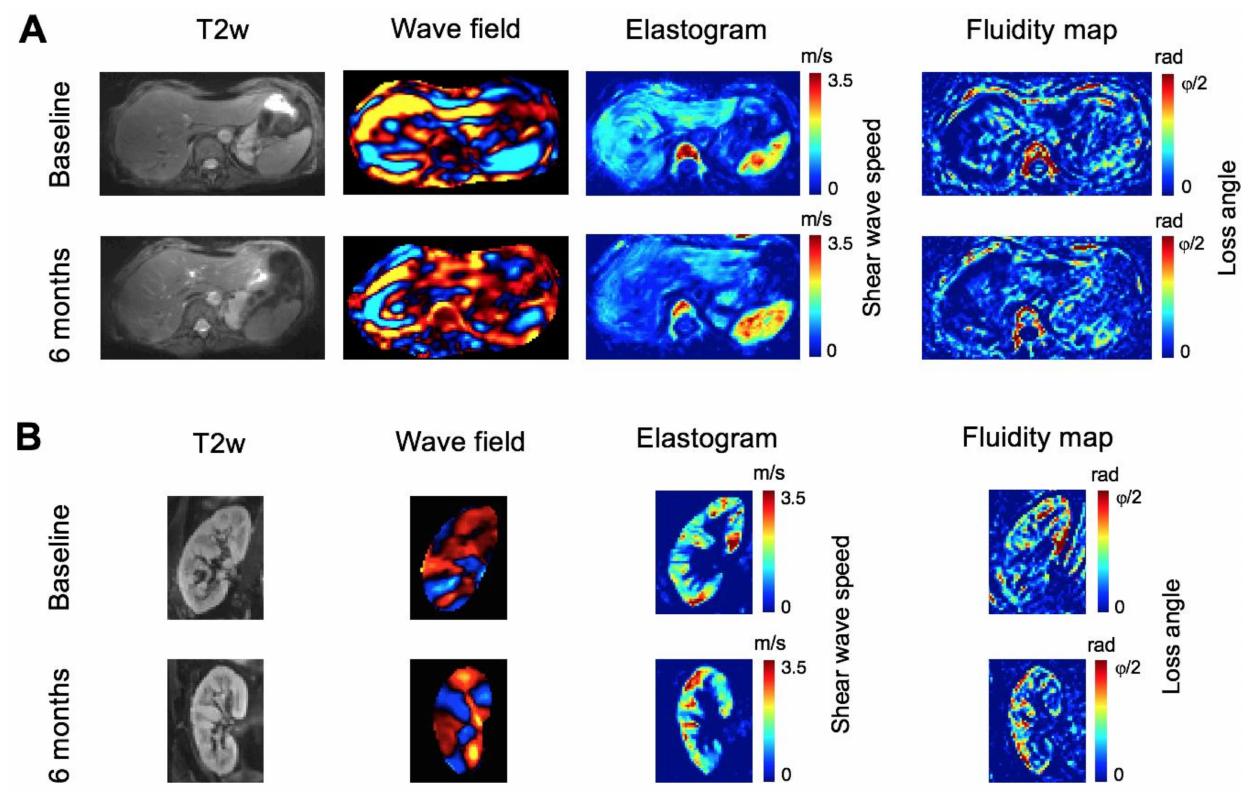
Figure 4. Representative MRE images. T2-weighted (T2w) images, tomoelastography wave-field images (50 Hz), elas- tograms and fluidity maps of the liver ( A ) and kidney allograft ( B ) at baseline and after 6 months (follow-up 1). Shear-wave speed and loss angle of the complex shear modulus increase in the liver after treatment with direct-acting antivirals, while both parameters increase in the kidney allograft.